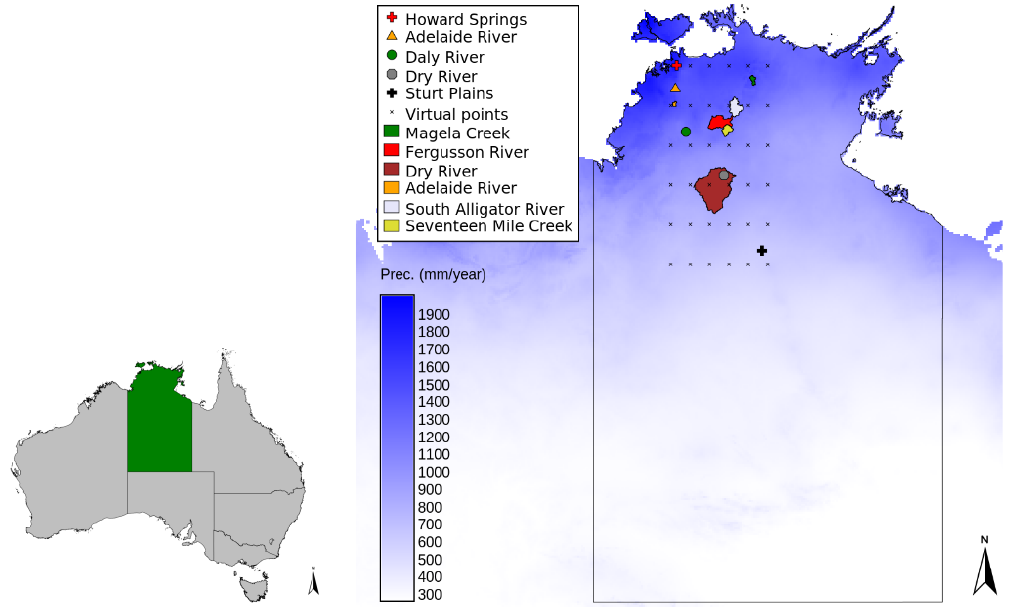
Figure 1. Catchments (polygons) and flux tower sites along the North Australian Tropical Transect (symbols), with additional locations shown as crosses. The mean annual precipitation is indicated by the blue color scale. Table 1. Characteristics of the study sites along the North Australian Tropical Transect, vegetation data from Hutley et al. (2011) and Whitley et al. (2016), with Eucalyptus (Eu.), Erythrophleum (Er.), Terminalia (Te.), Corymbia (Co.), Planchonia (Pl.), Themeda (Th.), Hetropogan (He.), and Chrysopogon (Ch.). Meteorological data are taken from the SILO data drill (Jeffrey et al., 2001) for the model periods of 1 January 1980 until 31 December 2017, including the Food and Agriculture Organization of the United Nations (FAO) Penman–Monteith potential evaporation (Allen et al., 1998). Aridity is defined as the ratio of net radiation to precipitation (multiplied by the latent heat of vaporization λ ), R n /(λP) . Tree cover is determined as the minimum value of the mean monthly projective cover based on remotely sensed observations of the fraction of photosynthetically active radiation (fPAR Donohue et al., 2008). The maximum grass cover was found by subtracting the tree cover from the remotely sensed projective